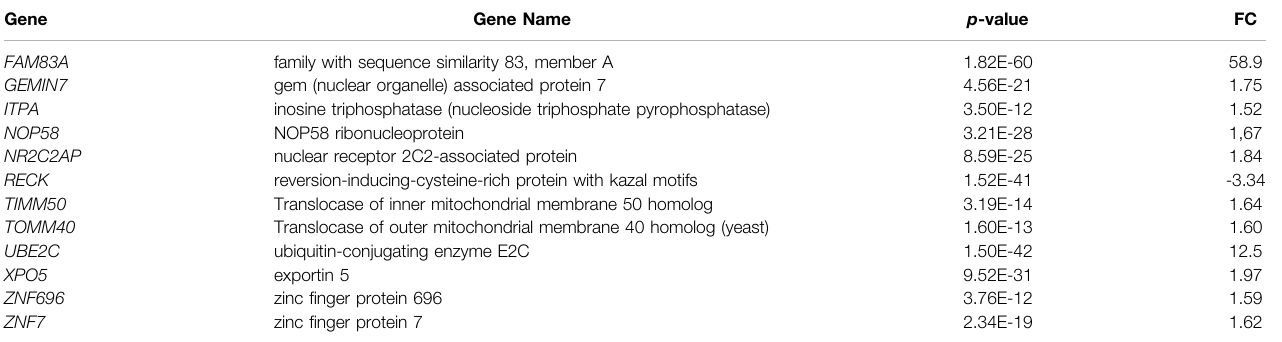
TABLE 1 | List of 12-gene signature that is identi fi ed in this study. Gene